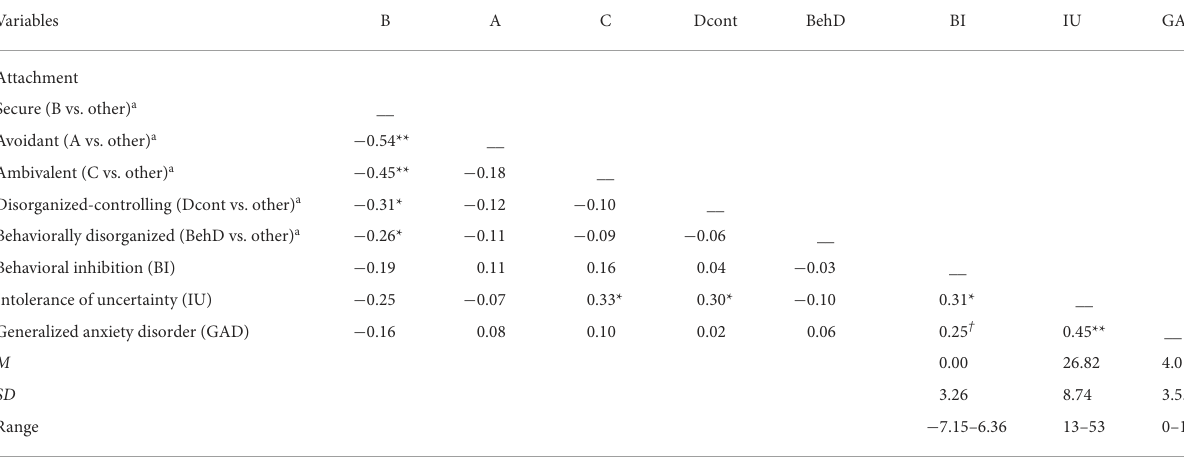
TABLE 1 Main study variables: Correlations and descriptive statistics ( N = 62). Variables B A C Dcont BehD BI IU